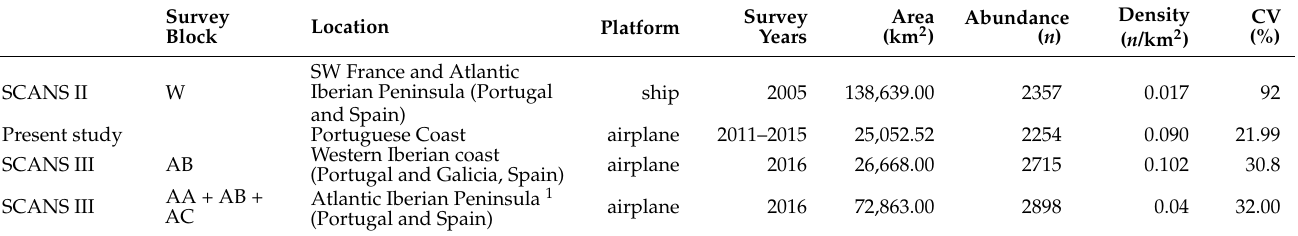
Table 5. Harbour porpoise abundance and density values (CV, confidence intervals) obtained in SCANS II [11] and SCANS III blocks that include the Iberian Peninsula [15], and in the present